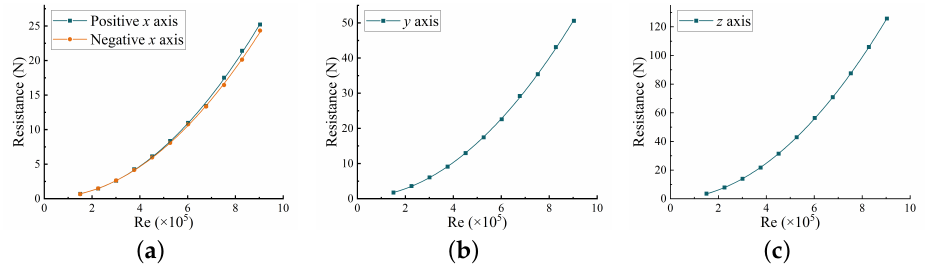
Figure 7. Change of resistance with respect to Re in towing test simulation. ( a ) Straight-line motion along x -direction; ( b ) straight-line motion along y -direction; ( c ) straight-line motion along z -direction. Table 4. Parameter settings of CFD method for steady motion simulation of the underwater vehicle. Parameters